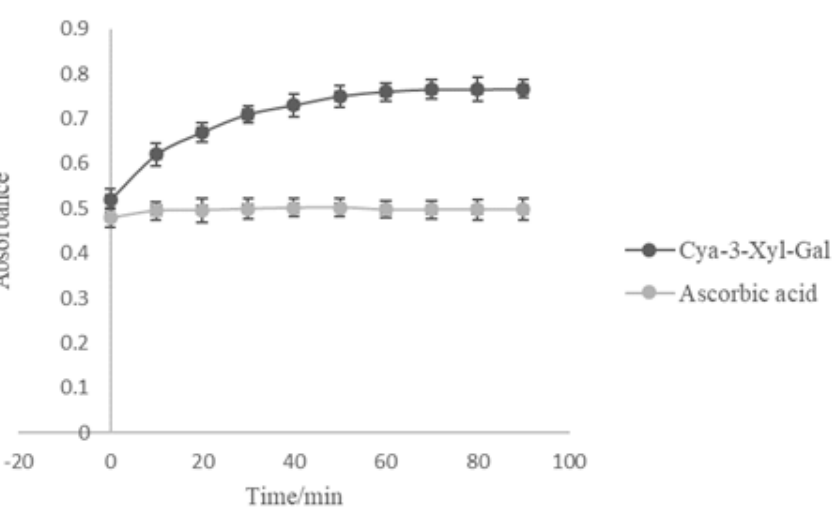
Figure 6. The aging curve of ferric-reducing antioxidant power at 0.1 mmol/L (ascorbic acid and Cya-3-Xyl-Gal).